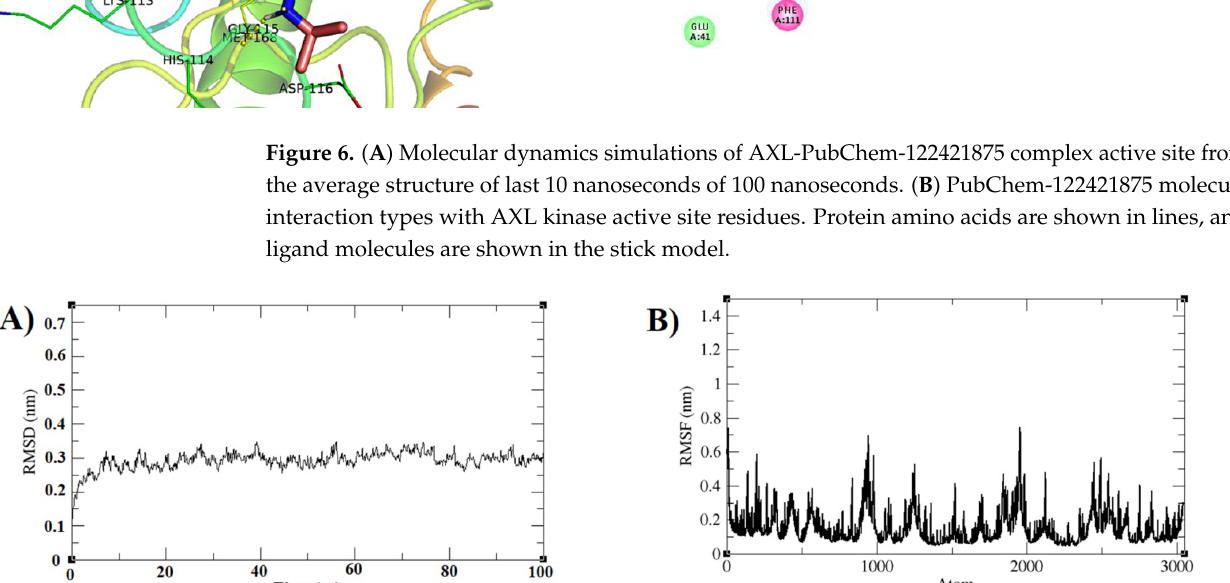
Figure 7. Plots generated from M159-bound AXL kinase (100 ns of MD simulations trajectory) ( A ) RMSD and ( B ) RMSF plots.